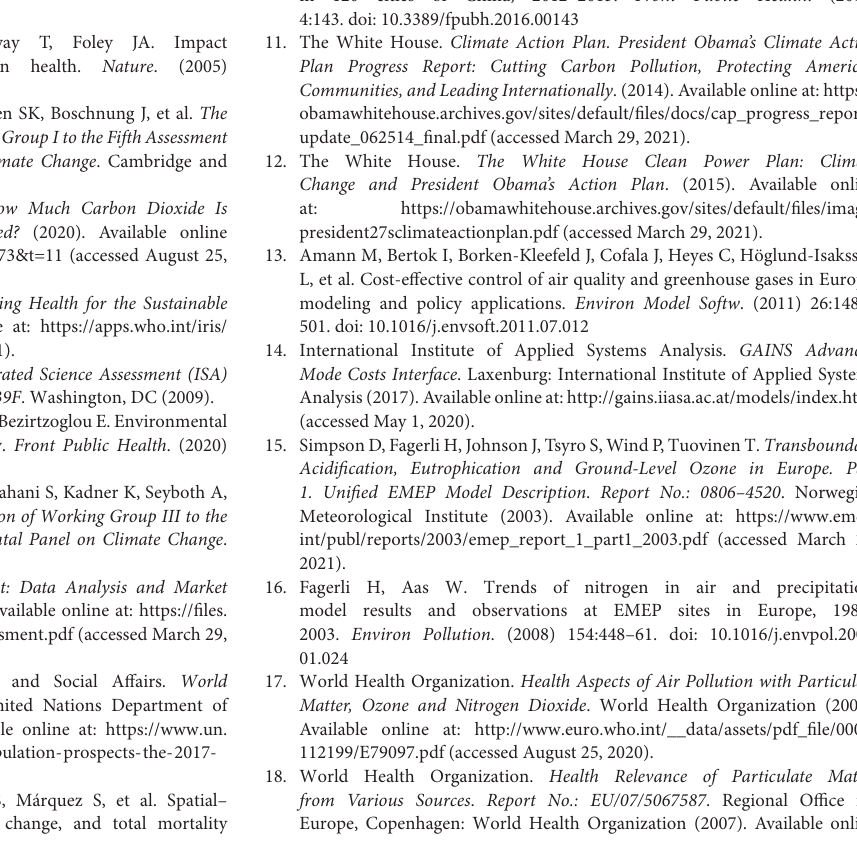
Emission control costs compared